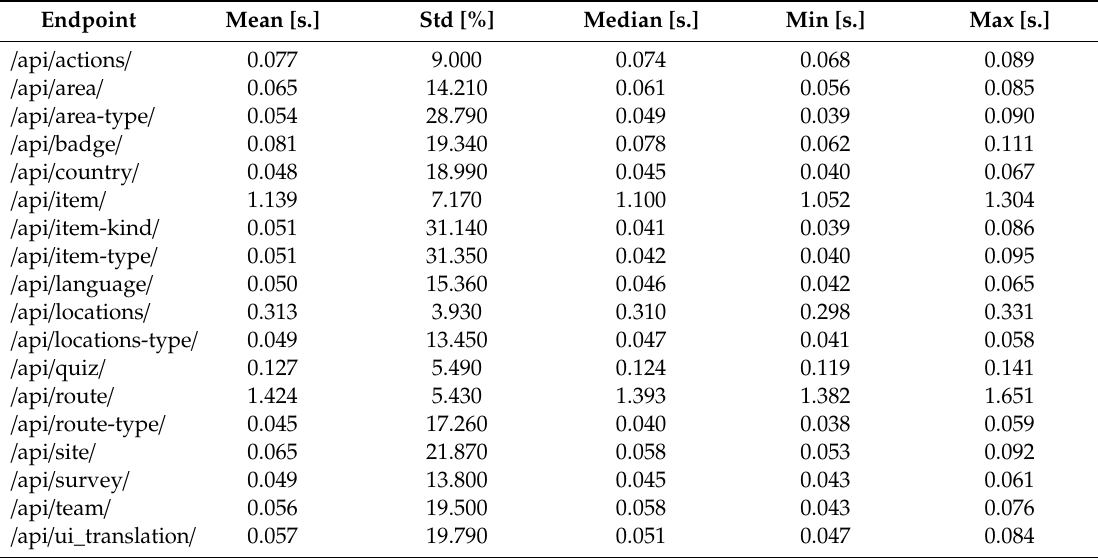
Table 10. Statistics on the most aggravating endpoints (1000 requests per